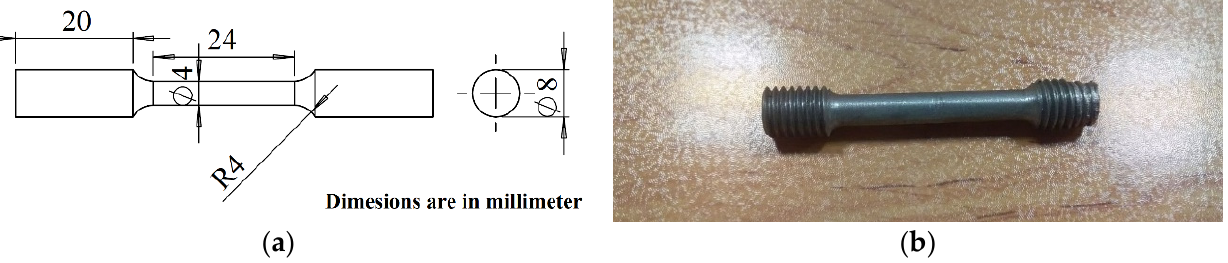
Figure 2. Specimen for the tensile test based on ASTM-E8: ( a ) 2D diagram; ( b ) fabricated specimen.